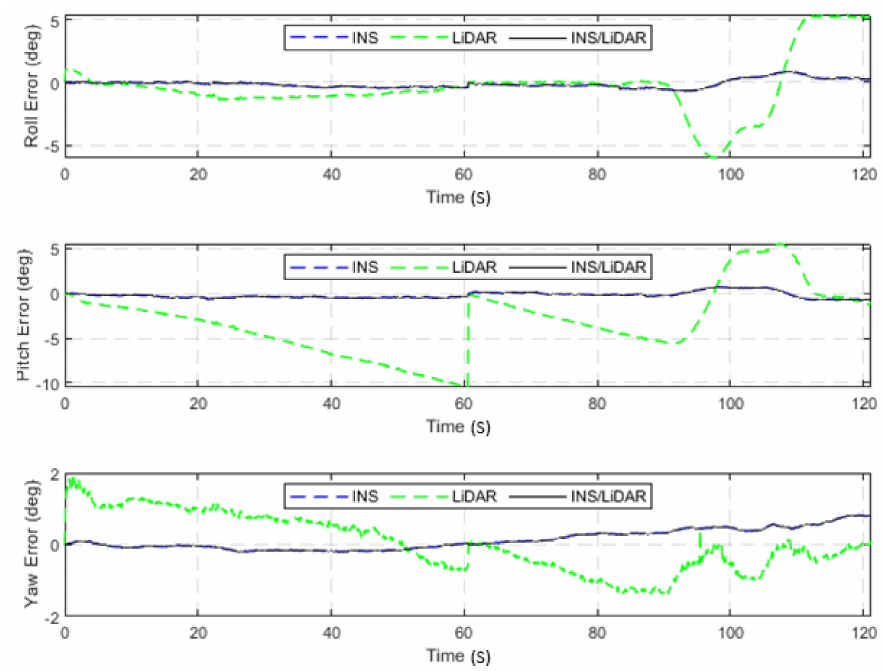
Figure 25. D-42—GNSS-assisted: errors of attitude angles (roll, pitch, and